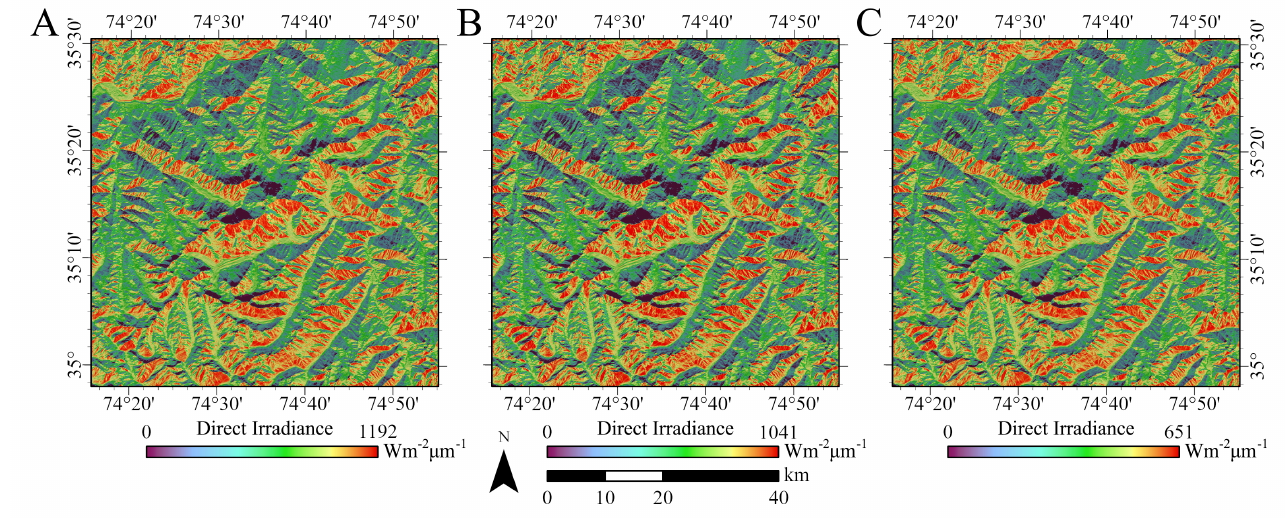
Figure 3. Direct irradiance simulation results over the Nanga Parbat Massif on 15 September 2022 at 10:00 a.m. ( A ). The green portion of the electromagnetic spectrum ( λ = 0.56141 µ m). ( B ). The red portion of the electromagnetic spectrum ( λ = 0.65459 µ m). ( C ). The near-infrared portion of the electromagnetic spectrum ( λ = 0.86467 µ m). The direct irradiance is superimposed over cos i using 50-percent